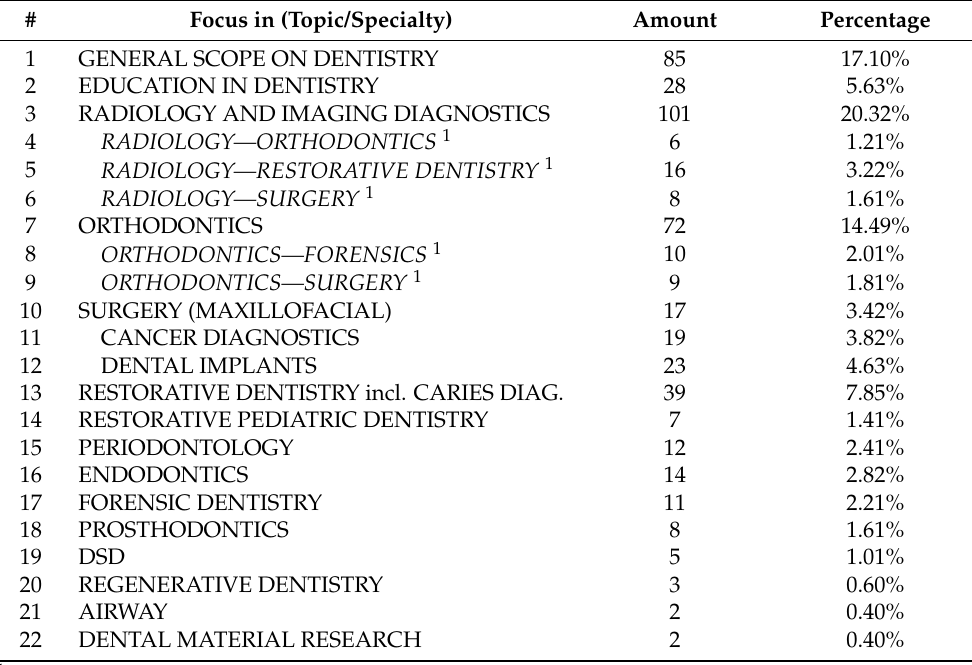
Table 4. Results of synthesis with qualitative variables (22) for classification of included recent studies.